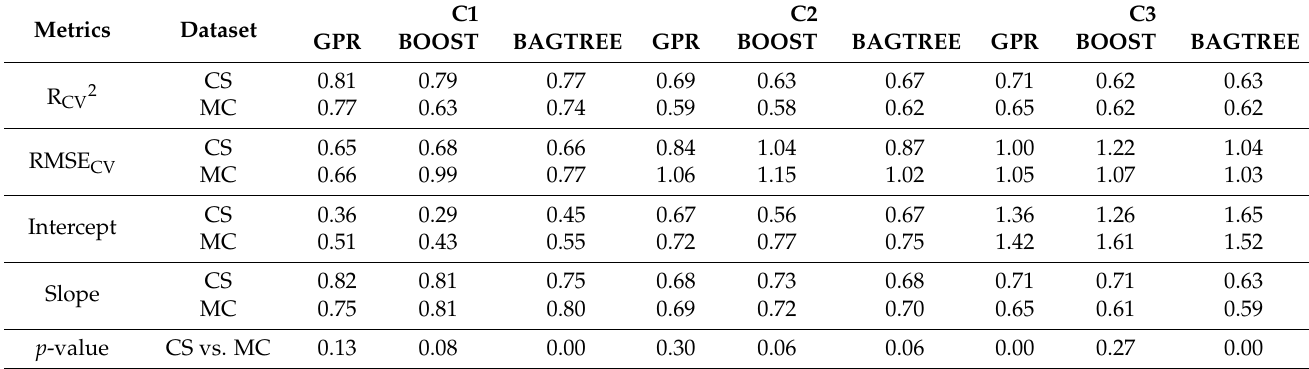
Figure 4. Validation results of LAI estimation at field level from SeLI, NDVI, and NBR by the inverse function improved with the conditional statement d (LogIF d ). Results per crop (C1, C2, and C3) of linear regression analysis between measured ground-LAI and LAI predicted from NDVI, SeLI, and NBR by the mixed-crop (MC) LogIF d (dashed line on black dots and equation in the box) and the crop-specific (CS) LogIF d (continuous line on white dots). Table 5. Cross-validation results of LAI estimation at pixel level from GPR, BOOST, and BAGTREE. The table reports, for each crop (C1 = winter wheat, C2 = maize, and C3 = alfalfa), the metrics obtained according to the parameterization made on the crop-specific (CS) and the mixed-crop (MC) data sets. The table reports the mean of coefficient of determination (R 2 CV ) and root mean square error (RMSE CV ) estimated from the k-fold cross validation procedure (k = 3); as well as the slope and the intercept of regression lines. p -values < 0.05 (*), < 0.01 (**), and < 0.001 (***) indicate significant differences between the predicted LAI with MC and CS data